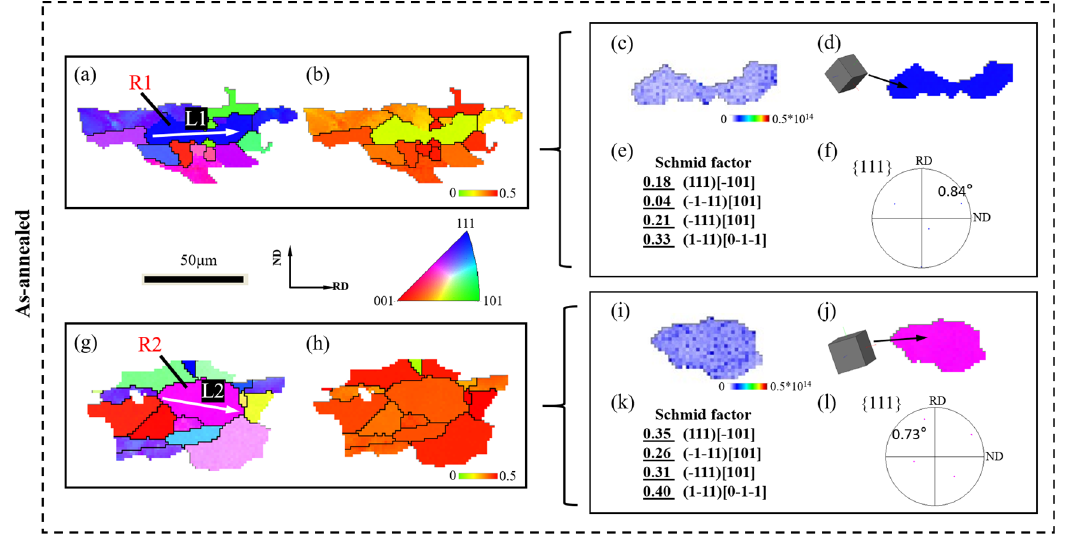
Figure 8. EBSD analysis of local area under as-annealed conditions: ( a ) IPF map of large SF grains, ( b ) SF map of large SF grains, ( c ) GND map of large SF grains, ( d ) grain orientation of large SF grains, ( e ) SF value of large SF grains, and ( f ) PFs of large SF grains; ( g ) IPF map of small SF grains, ( h ) SF map of small SF grains, ( i ) GND map of small SF grains, ( j ) grain orientation of small SF grains, ( k ) SF value of small SF grains, and ( l ) PF of small SF grains.